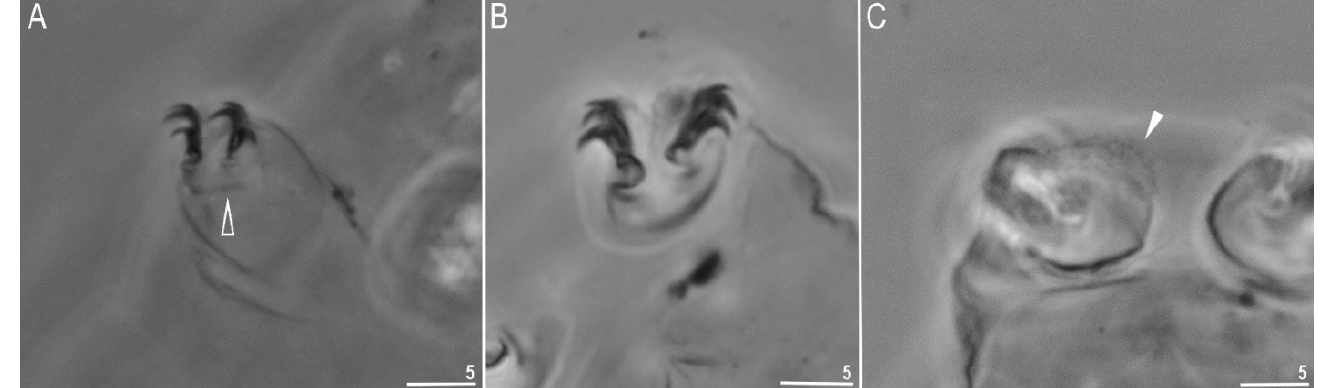
Figure 3. Minibiotus intermedius : ( A ) claws I, empty arrowhead indicates double muscle attachments under the claws. (paratype); ( B ) claws IV (neotype); ( C ) filled arrowhead indicates granulation on leg IV (neotype). All in PCM. Scale bars in μ m.